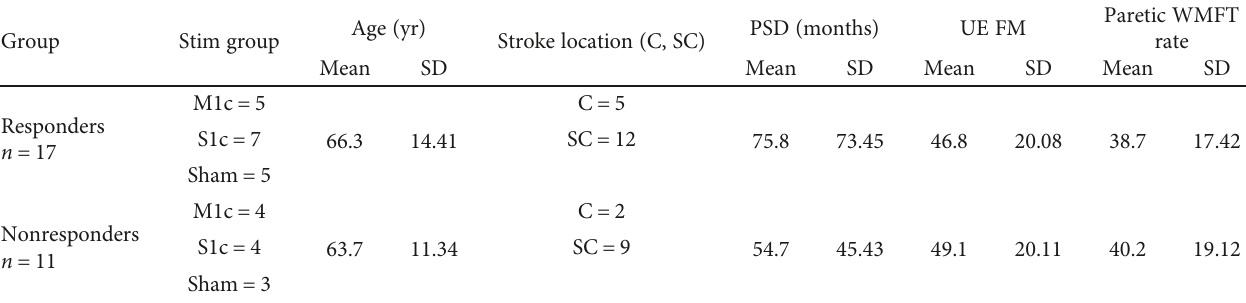
C=cortical; M1c= contralesional primary motor cortex; PSD =poststroke duration; S1c= contralesional primary somatosensory cortex; SC= subcortical; UE FM= upper-extremity Fugl Meyer; WMFT=Wolf Motor Function